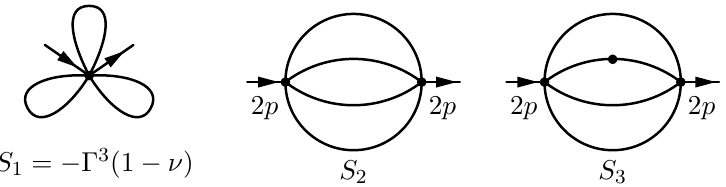
Figure 1 . Master integrals. Solid lines correspond to the propagators 1 = ( k 2 (cid:0)